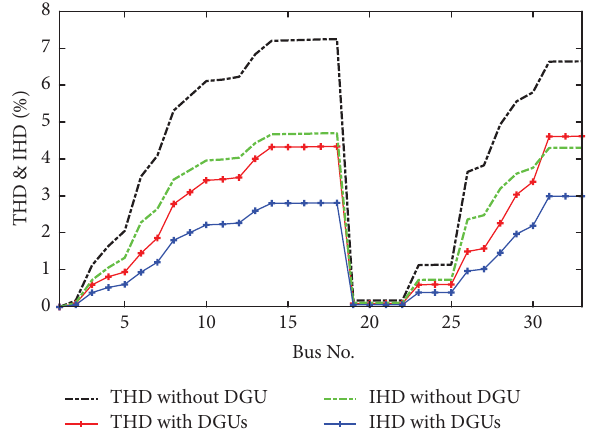
Figure 9: THD (%) and IHD (%) of the IEEE 33-bus system before and after DGUs connection.